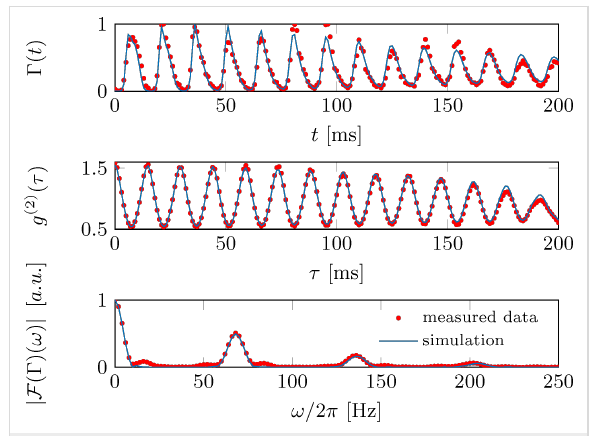
The autocorrelation function shows a nicely damped oscillation which can be used to extract the tip’s oscillation frequency. The same information can be obtained from the Fourier transform.